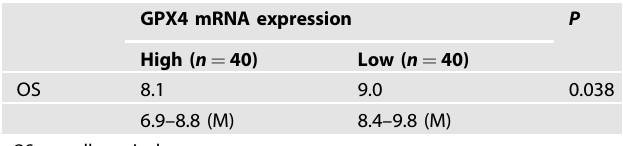
Table 2. GPX4 expression and clinical outcome of advanced RCC patients.